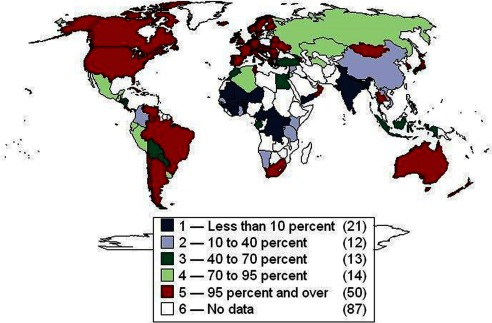
Universal Health Coveragea: The New Frontier for Global Healtha The graph assesses the proportion of the population affiliated with national health insurance or social, private, or micro- insurance schemes.Source: This graph was first published in Garret (2009)39 and later updated in the International Labour Organization (2017).41